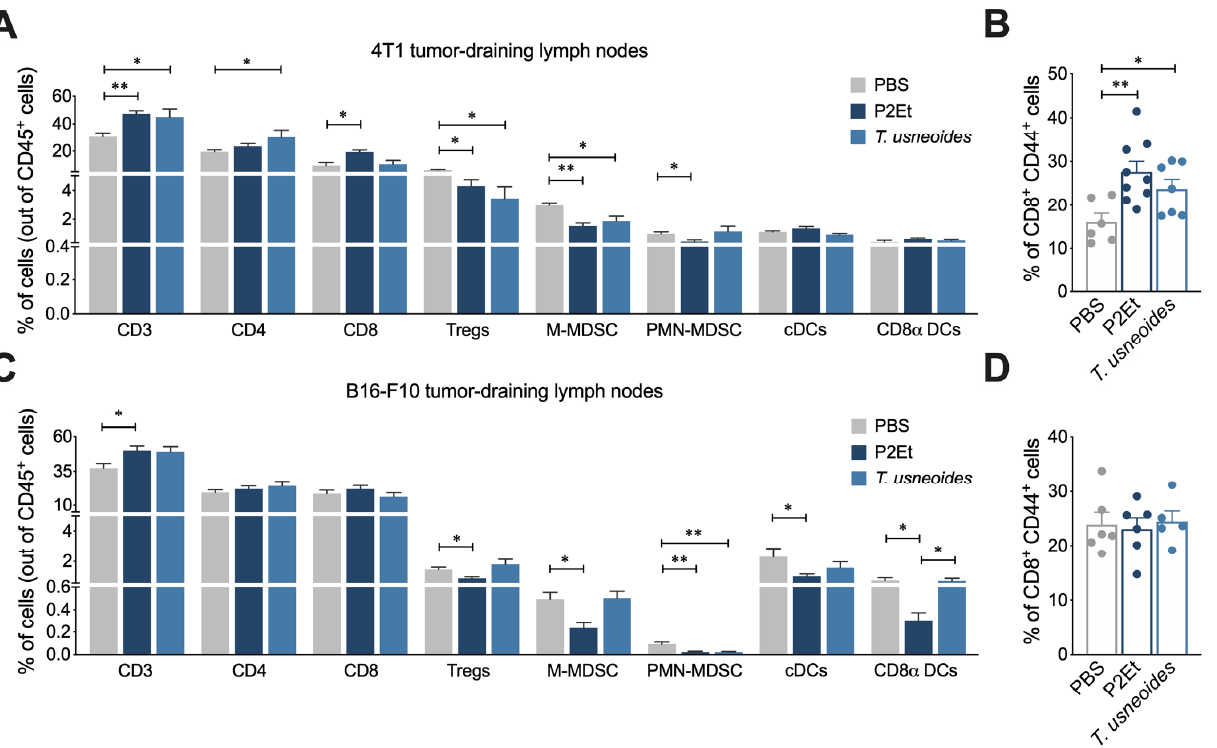
Figure 5. Treatment of T. usneoides in vivo modulates the immune response in lymph nodes. ( A ). Overview of the immune cell composition in lymph nodes from 4T1 tumor bearing mice shown in percentage of cells on a per ‐ mouse basis. ( B ). Frequency of activated CD8 + T cells. ( C ). Overview of the immune cell composition in lymph nodes from B16 ‐ F10 tumor bearing mice shown in percentage of cells on a per ‐ mouse basis. ( D ). Frequency of activated CD8 + T cells. In all cases, data are represented as the mean ± SEM. The p values were calculated using the Mann–Whitney U test. * p < 0.05, ** p <